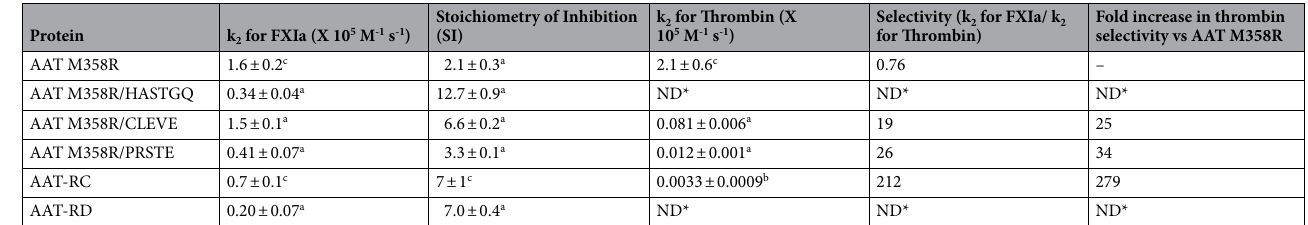
Table 1. Kinetic parameters for single and double motif AAT variants compared to AAT M358R. The mean of 5 a , 7 b , 9 c , or 10 d determinations ± one standard deviation is shown, for kinetic parameters for single and double motif AAT variants, compared to AAT